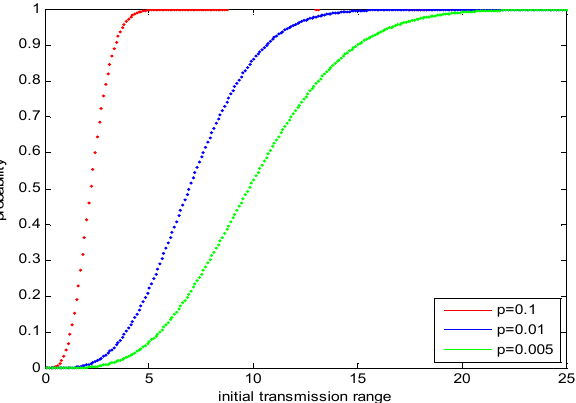
Figure 22. The probability under different node density and original transmission range in homogeneous networks.